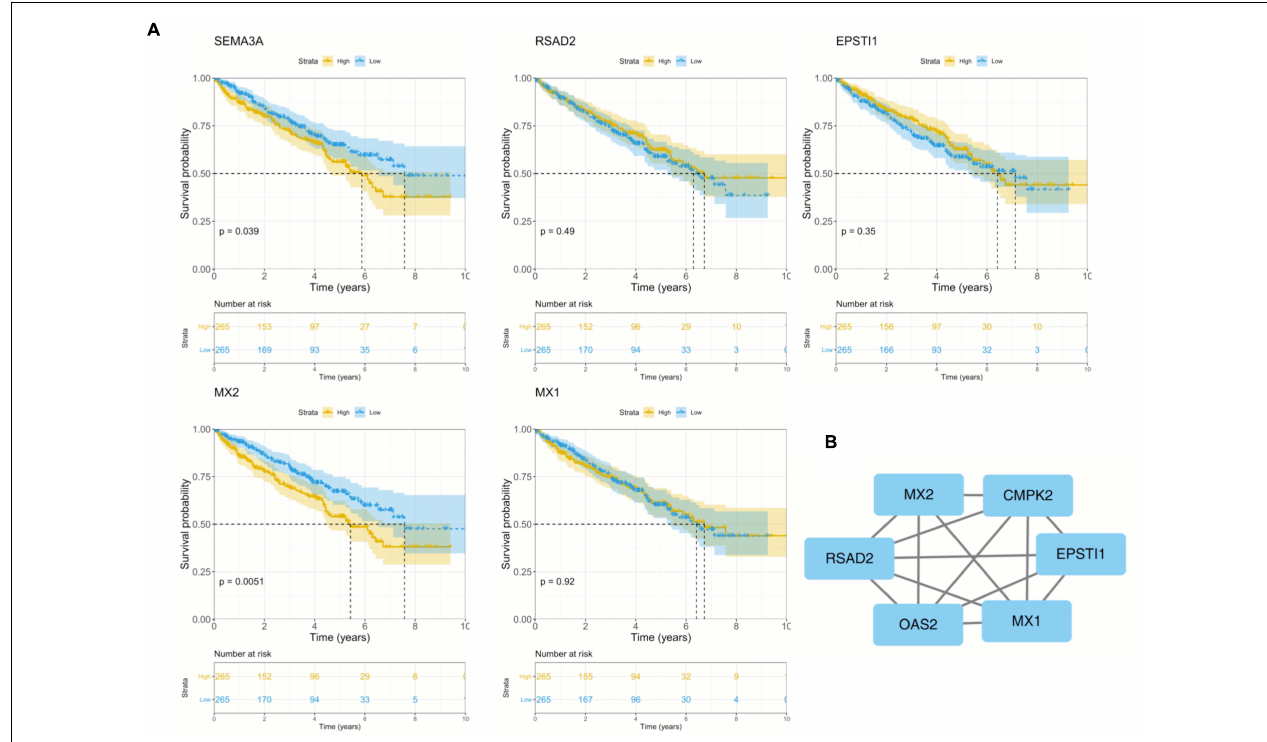
FIGURE 4 | Survival analysis and PPI network of five hub genes. (A) Kaplan–Meier curves of five hub genes in TCGA cohort. (B) Representative PPI network of hub genes. PPI, protein–protein interaction; TCGA, The Cancer Genome